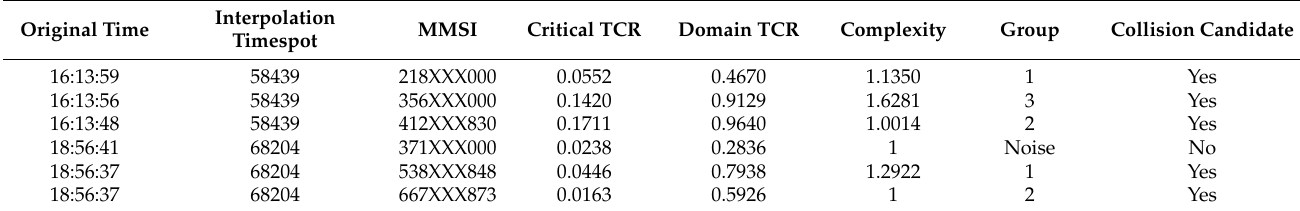
Table 2. Results of collision risk analysis for certain ships in the